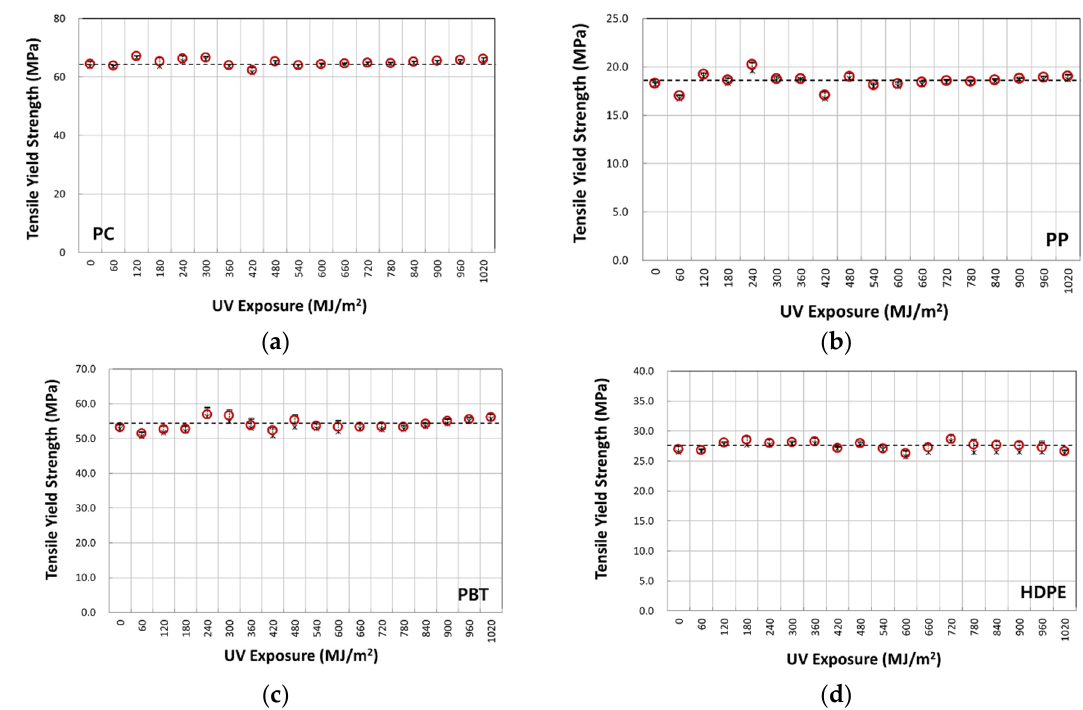
Figure 9. Variation of tensile yield strength with UV irradiation dose: ( a ) PC; ( b ) PP; ( c ) PBT; and ( d ) HDPE.